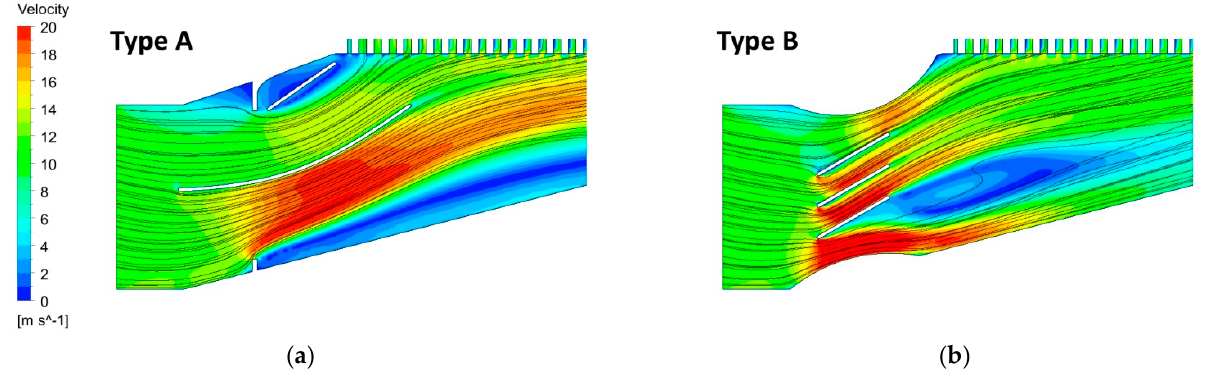
Figure 14. Streamlines and velocity profile of the modified cooling duct in ( a ) Type A and ( b ) Type B.